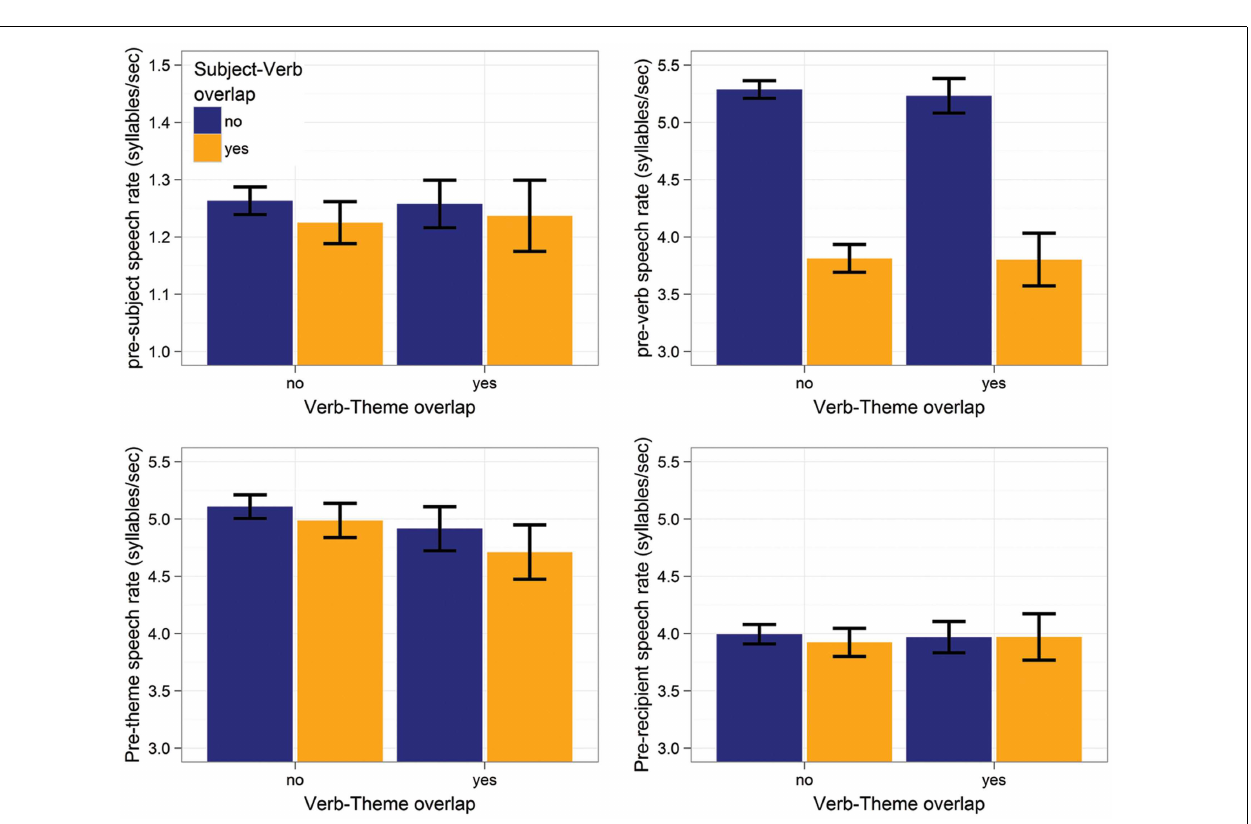
FIGURE 5 | Effects of subject-verb and verb-theme overlap on speech rate in the pre-subject (top-left), pre-verb (top-right), pre-theme (bottom-left), and pre-recipient region (bottom-right) Error bars give 95% non-parametric confidence interval .